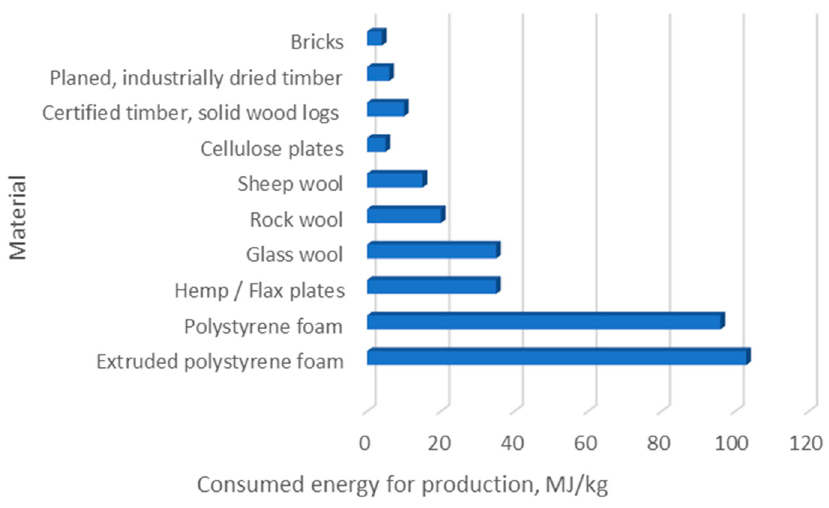
Figure 1. Consumed energy for thermal insulation and construction materials.